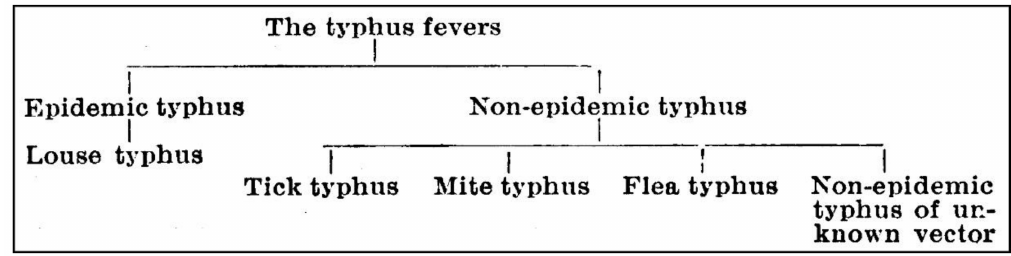
Figure 1. Megaw’s scheme identifying the forms of typhus present in India and Southeast Asia